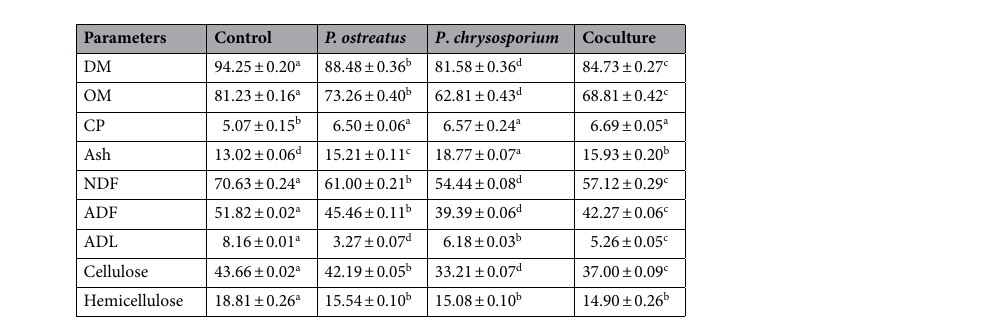
Table 1. Chemical composition (%) of rice straw after incubation with axenic and coculture white-rot fungi. All values are mean ± standard error. a–d Values with different superscript letters in a row represent significant difference ( P <